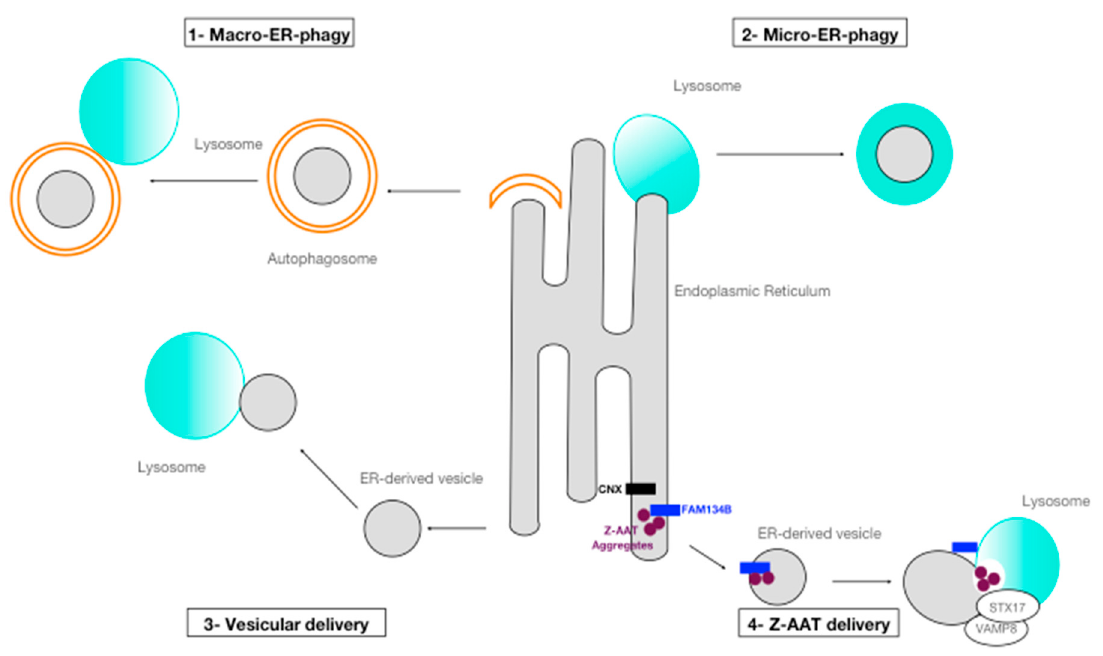
Figure 3. ER-phagy. (1) Macro-ER-phagy: fragments of the endoplasmic reticulum (ER) are enclosed in an autophagosome which fuses with a lysosome for degradation. (2) Micro-ER-phagy: a small portion of the ER is directly engulfed by inward invagination of the lysosomal membranes and then degraded. (3) Vesicular delivery: small vesicles containing misfolded proteins bud off from the ER and directly fuse with lysosomes. (4) Z-AAT delivery: calnexin (CNX) segregates proteasome-resistant Z-AAT aggregates in FAM134B-decorated ER subdomains. The SNARE proteins STX17 and VAMP8 regulate fusion of Z-AAT-containing ER-derived vesicles with lysosomes